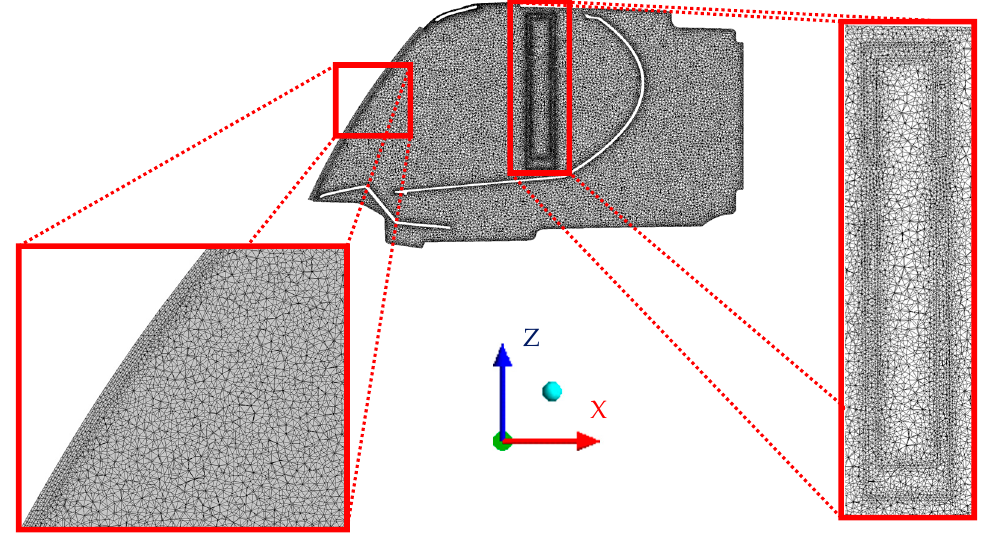
Figure 6. Cross section of the mesh with detailed view of the front glass and humidifier areas.